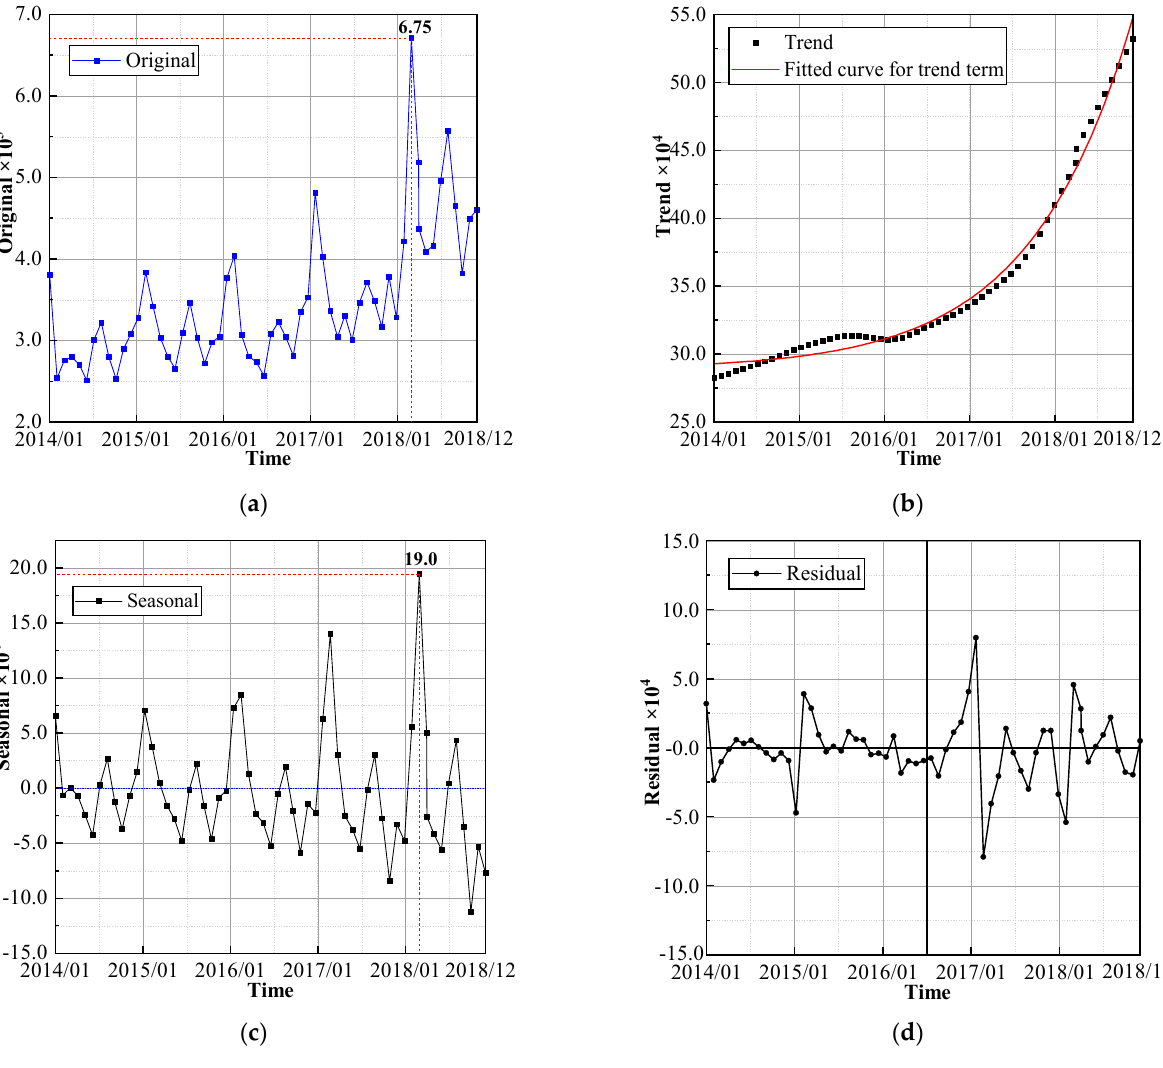
Figure 3. The time series of traffic flow and its breakdown from January 2014 to December 2018.